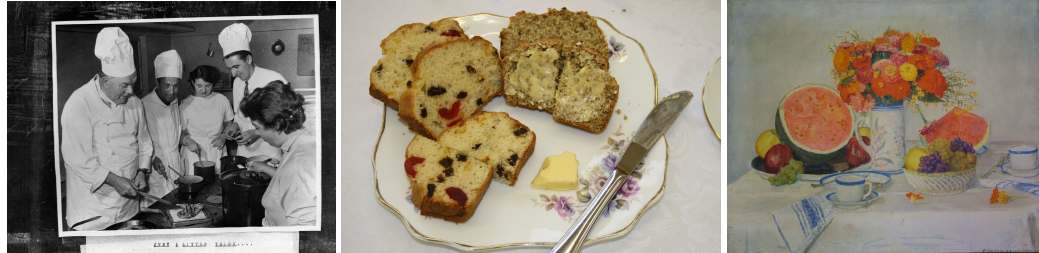
Figure 2. Sample food images selected from